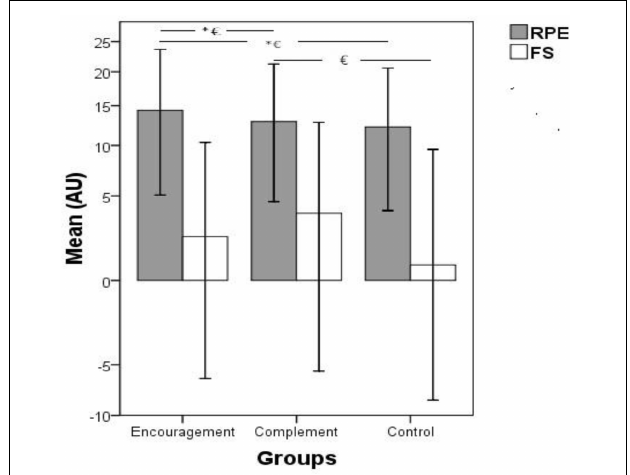
FIGURE 2 | Rate of perceived exertion and feeling scale after the repeated change of direction test. RPE, rate of perceived exertion; FS, feeling scale. *Significant difference between groups on RPE; £ significant difference between groups on FS. Data are presented as mean ±